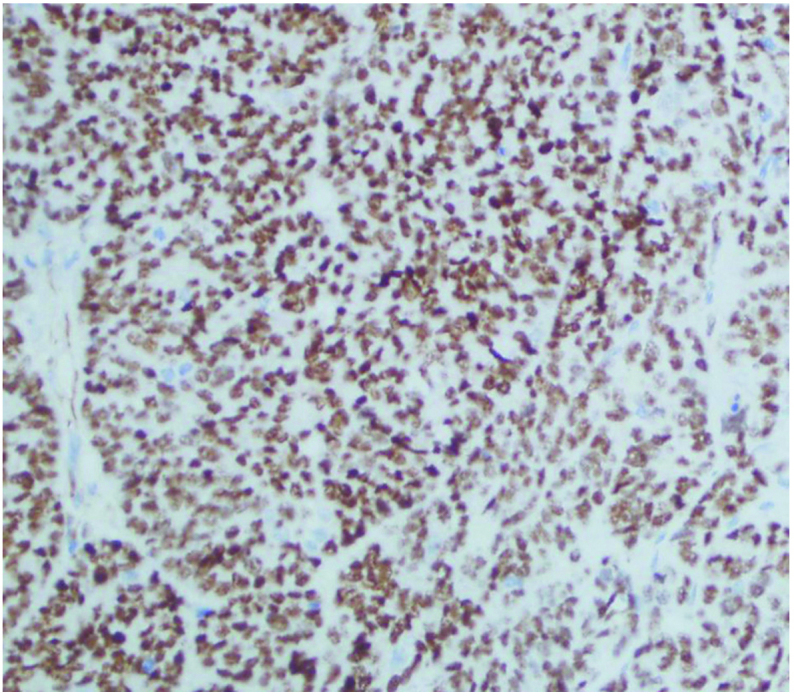
Immunohistological analysis of HIF-1α protein in ovarian cancer tissue (magnification, x100). HIF-1α, hypoxia-inducible factor-1α.